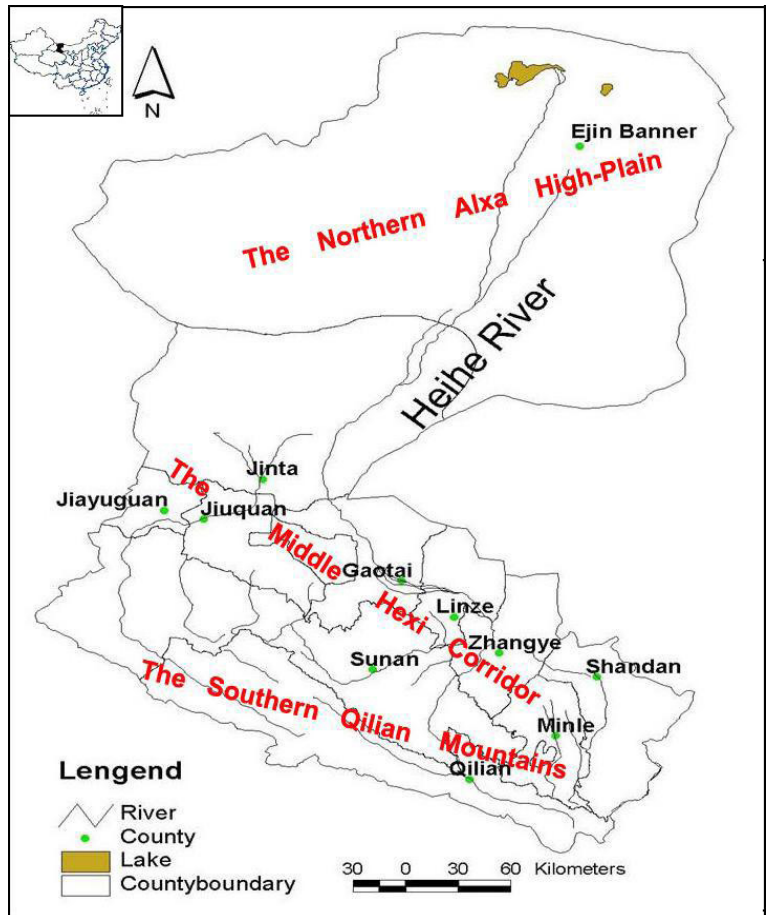
Figure 1. Location map of the Heihe River Basin in arid Northwest